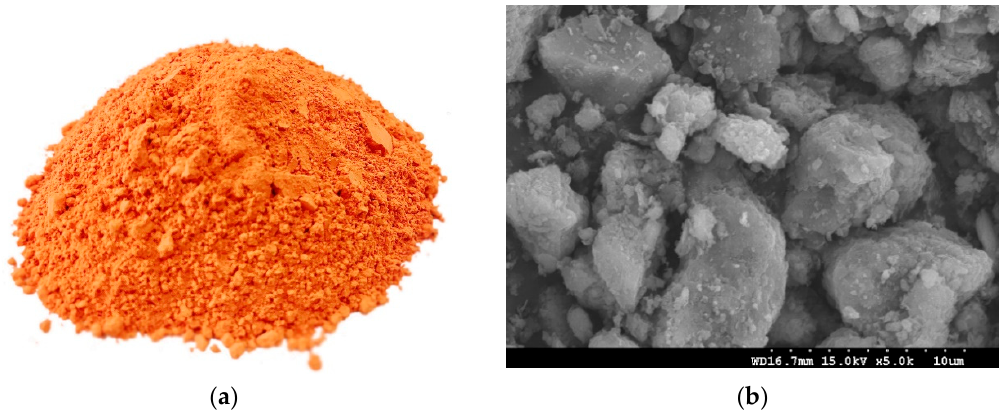
Figure 3. ( a ) Calcined Hwangtoh powder. ( b ) SEM micrographs of calcined Hwangtoh.